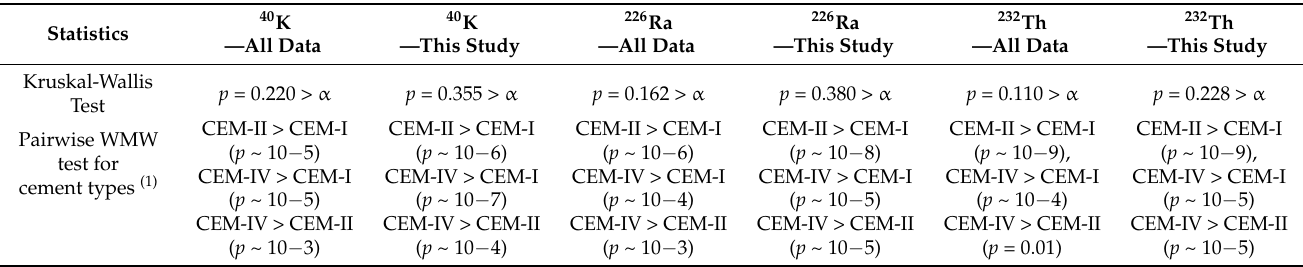
Table 7. Results of Kruskal–Wallis and pairwise Wilcoxon–Mann–Whitney tests which, at a given significance level, compare means of the features within given groups. In this article the features are activity concentrations of the radionuclides, first for all collected data from Table 4 for which the information on cement type was provided, next for the authors’ own data only. The groups, in turn, are cement